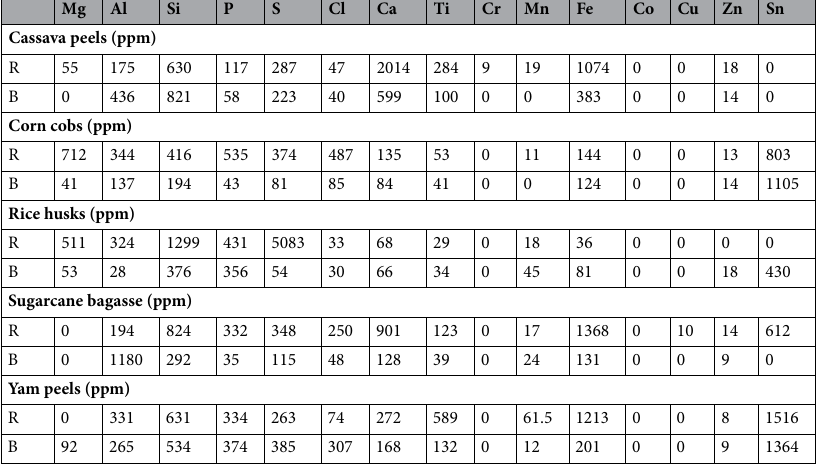
Table 5. Effect of alkaline pretreatment on the raw biomass samples. R—Raw biomass sample. B—Alkaline